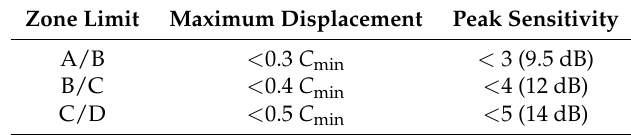
Figure 18. Closed-loop system block diagram with disturbances. Table 3. Recommended criteria of zone limits in ISO 14839